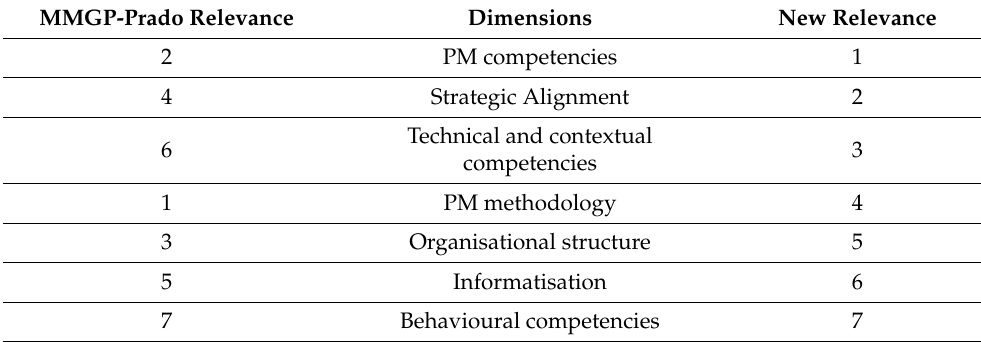
Table 5. Dimensions relevance: MMGP-Prado vs. New